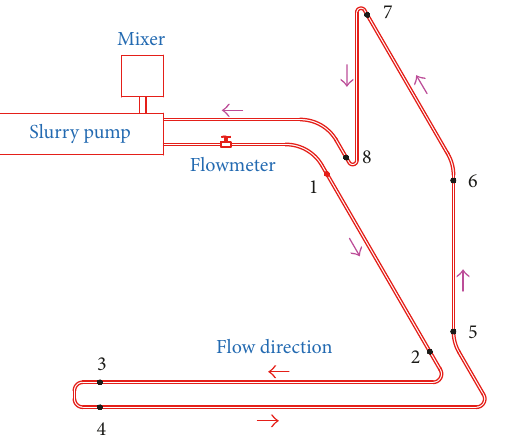
Figure 6: Layout of the loop system.